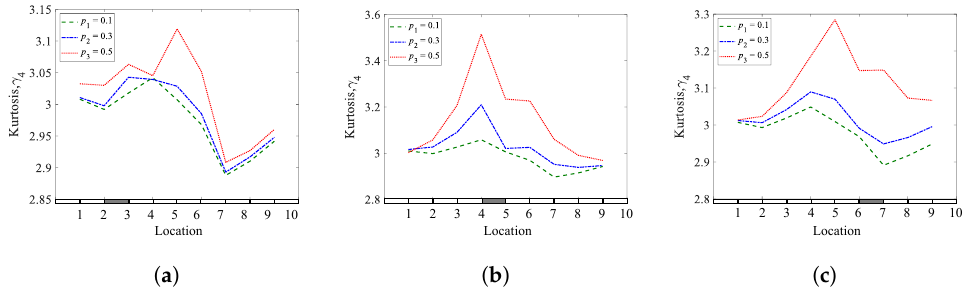
Figure 17. Kurtosis coefficients of a fixed-fixed beam for different crack depths and locations: ( a ) q 1 = 0.25; ( b ) q 2 = 0.45; ( c ) q 3 = 0.65.